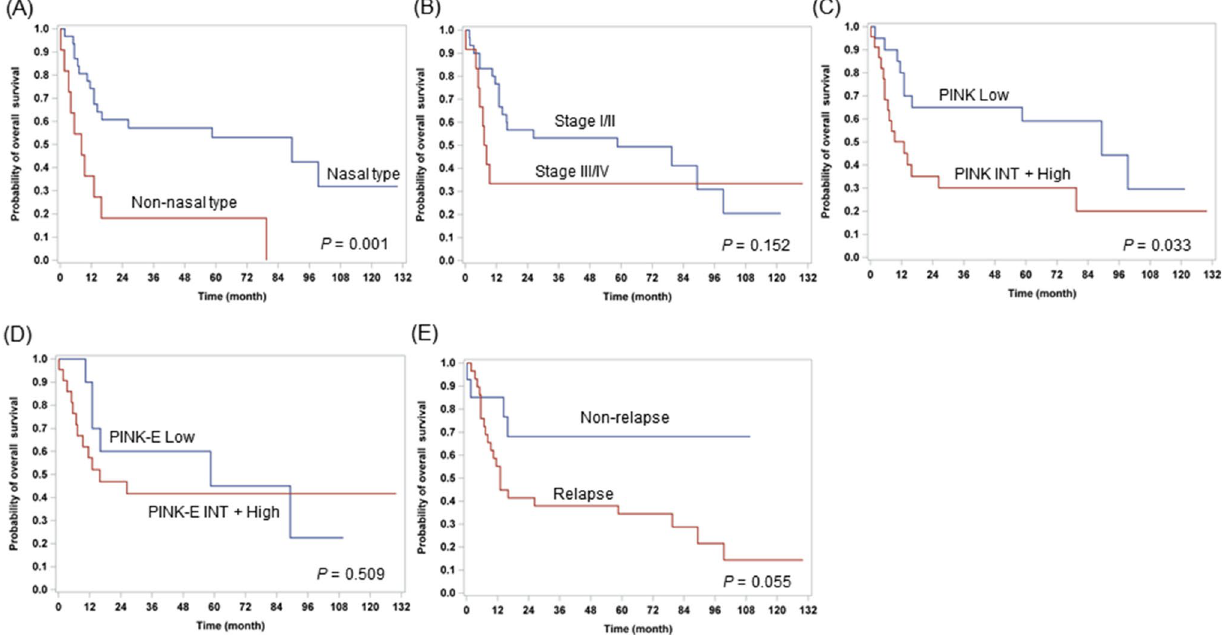
Figure 1. Kaplan–Meier survival curves for ENKTL patients based on primary site ( A ), Ann Arbor stage ( B ), PINK risk group ( C ), PINK-E risk group ( D ), and relapse ( F ). Data for PINK-E were obtained from the patients with available EBV data. ENKTL, extranodal natural killer T-cell lymphoma; PINK, prognostic index for natural killer lymphoma; PINK-E, prognostic index for natural killer lymphoma–Epstein–Barr virus; Epstein–Barr